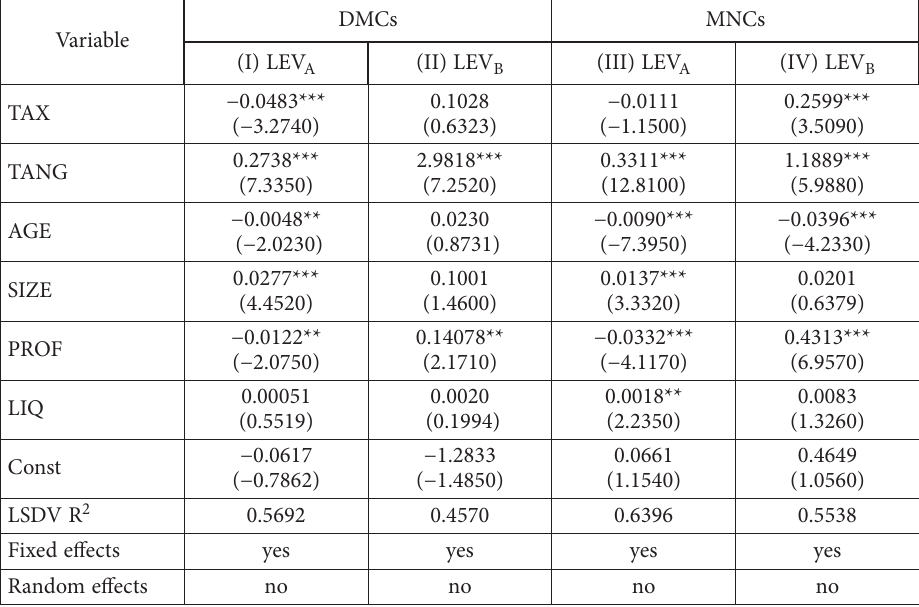
Table 8. Regression results: